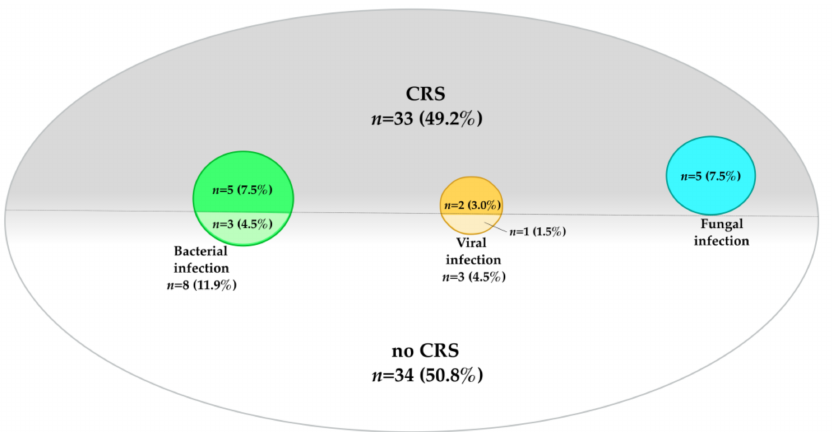
Figure 2. Distribution of infection and CRS. This graphic shows the distribution of infections— divided into bacterial ( n = 8, 11.9%), viral ( n = 3, 4.5%) and fungal ( n = 5, 7.5%) origin and CRS ( n = 33, 49.2%). Furthermore, infections with simultaneous CRS ( n = 12, 17.9%) are